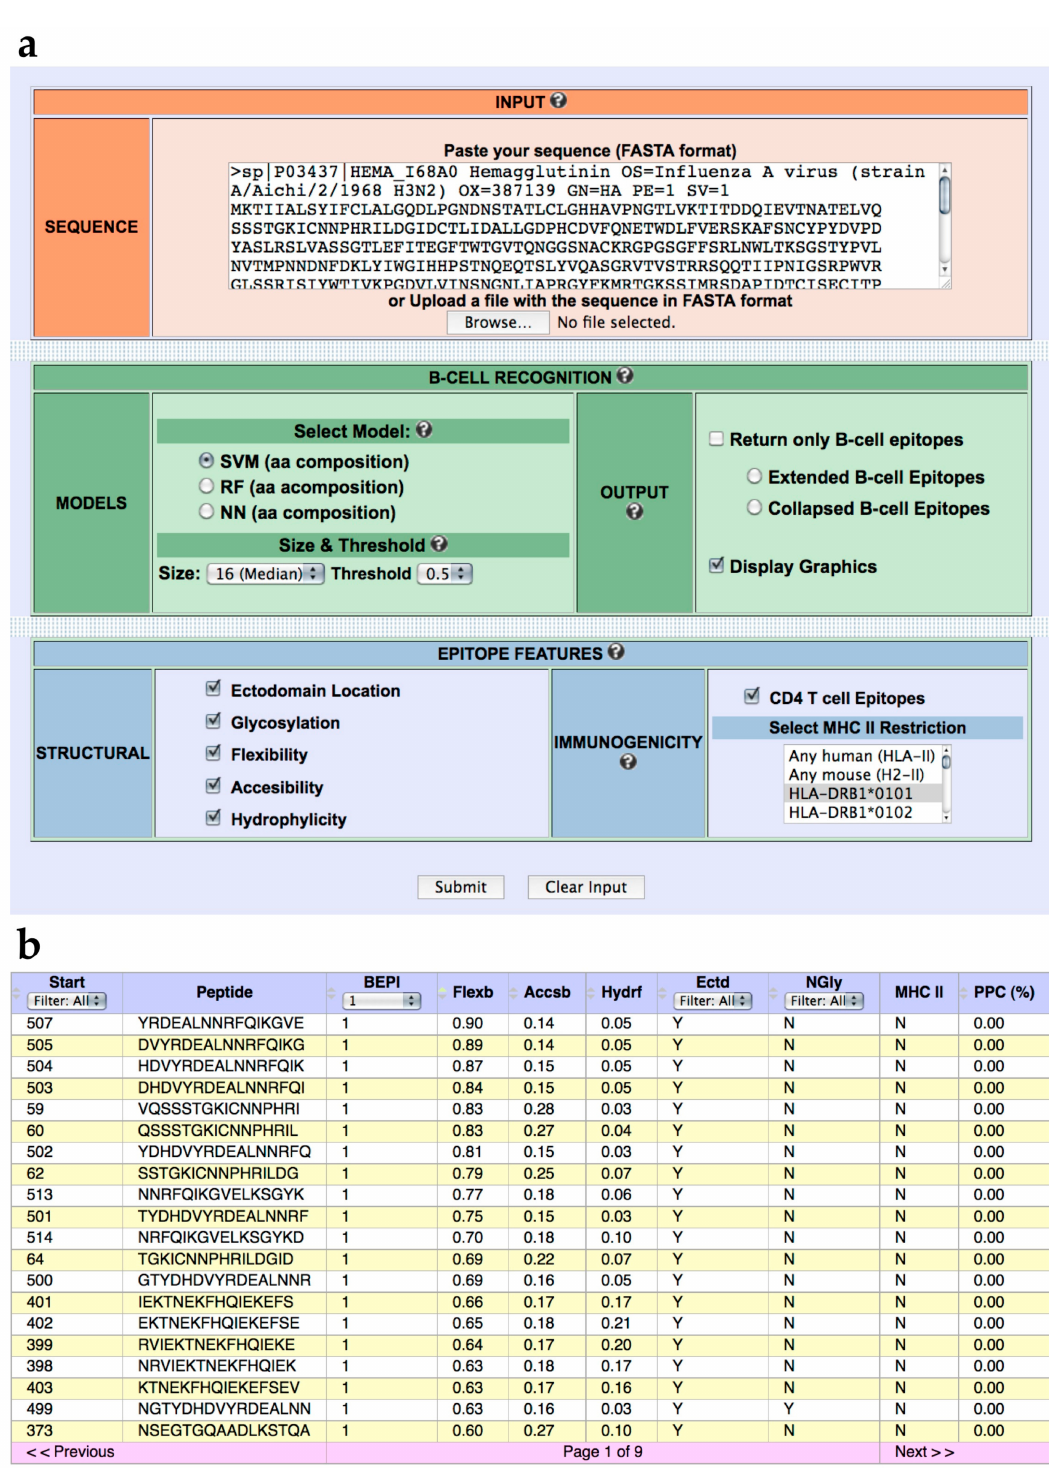
Figure 2. BCEPS web server. ( a ) BCEPS interface. ( b ) Representative BCEPS output obtained with default settings and the option “Extended B cell epitopes”. BCEPS main result consists of a table displaying the following information (from left to right): Peptide starting position; peptide sequence; B cell epitope prediction (1/0); flexibility value; accessibility value; hydrophilicity value; ectodomain location (Y/N); presence of N-glycosylation sites (Y/N); user selected MHC II molecules predicted to bind the peptide; and population protection coverage (only applies to human MHC II